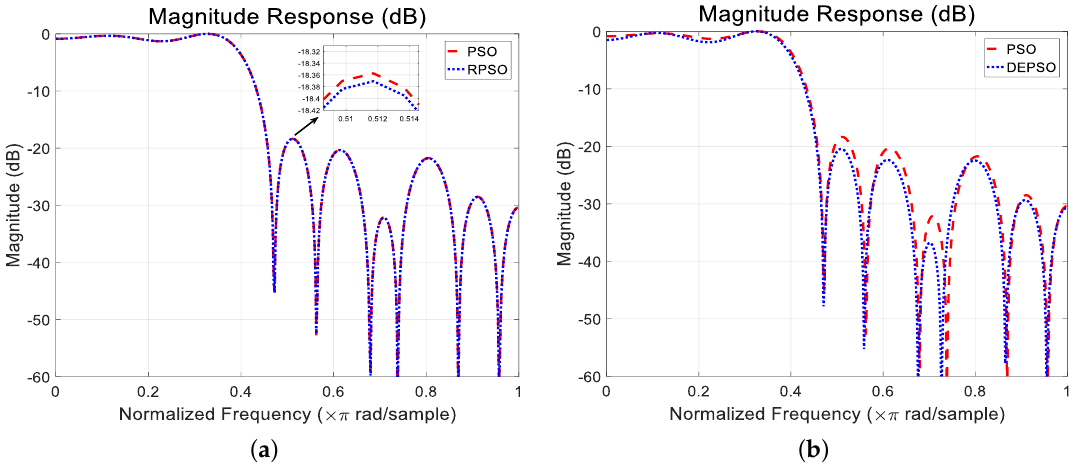
Figure 7. ( a ) Frequency responses of the designed filters by the PSO algorithm and the RPSO algorithm. ( b ) Frequency responses of the designed filters by the PSO algorithm and the DEPSO